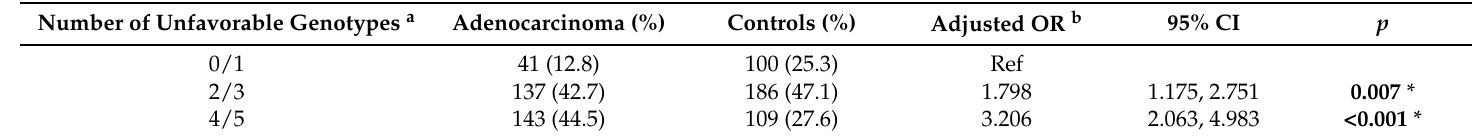
Table 6. Cumulative effect of unfavorable genotypes and lung adenocarcinoma